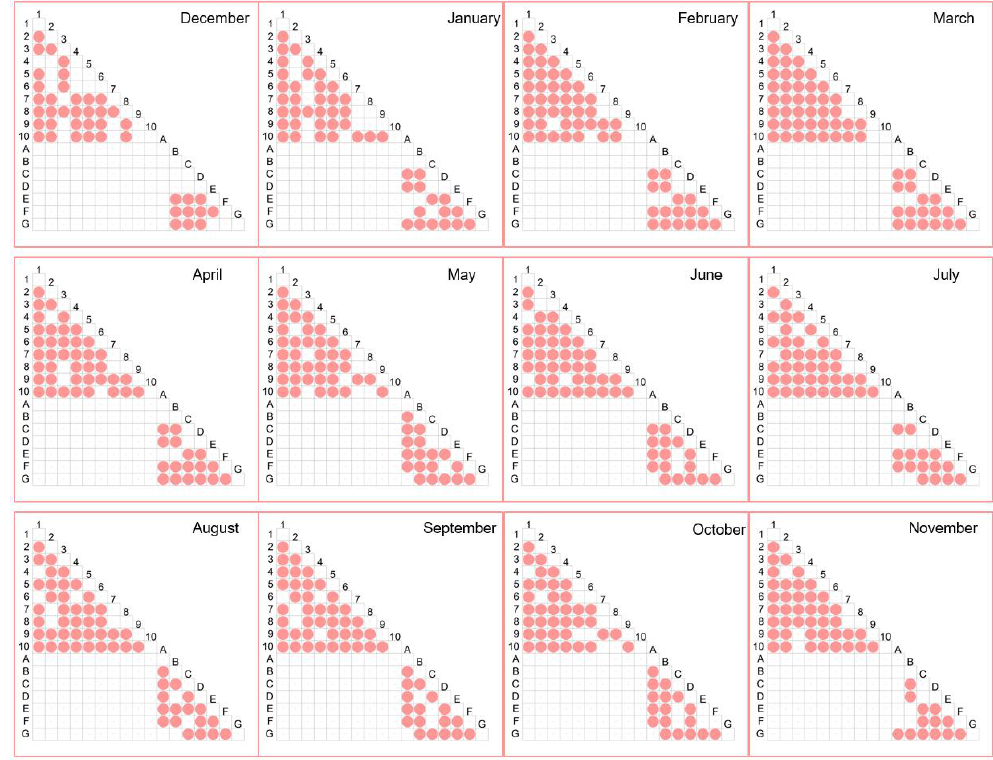
Figure 8. Difference of land surface temperatures of local climate zone types within an urban context (Circle denotes significant difference at p < 0.05 level, blank demotes no significant difference).